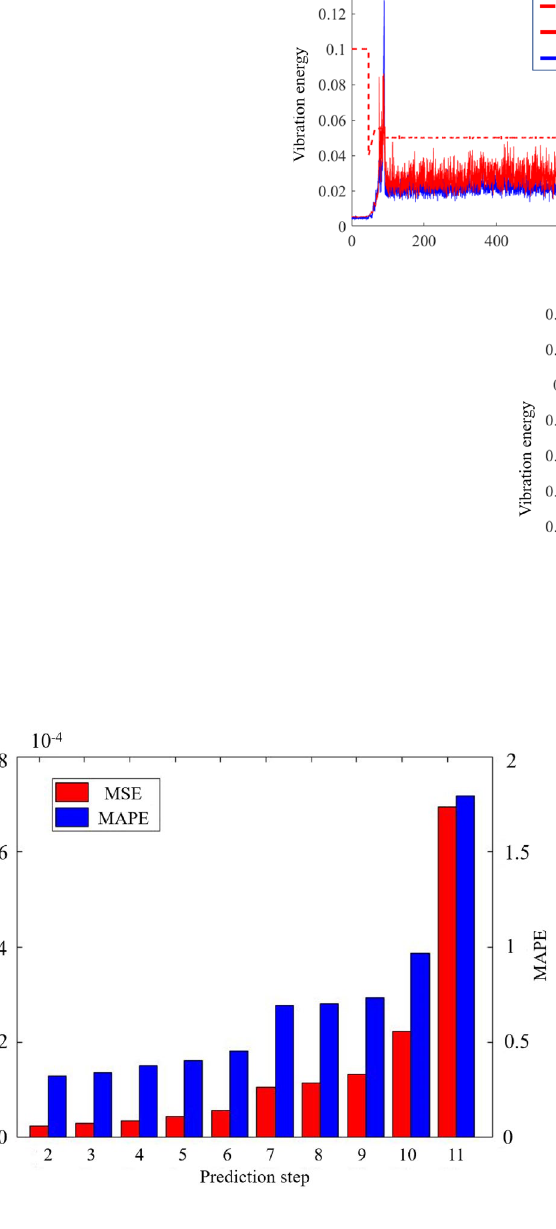
Fig. 12 Evaluation criteria under different prediction step